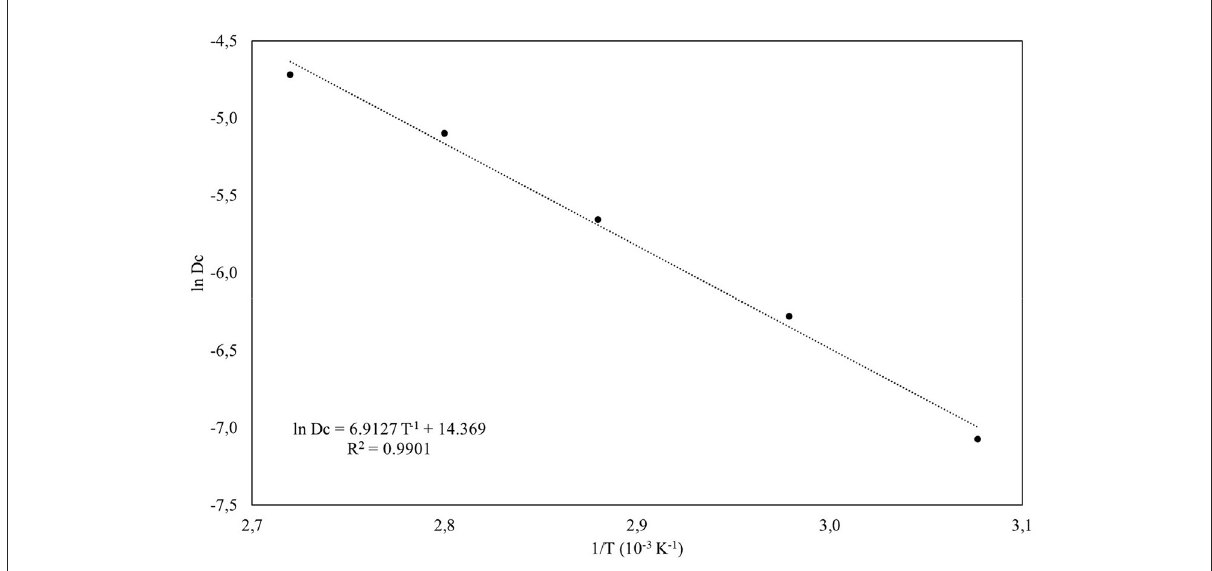
FIGURE7 Activation energy (Ea) stimation of the pigments produced by Monascus ruber CCT 3802 in submerged culture by Arrhenius model.